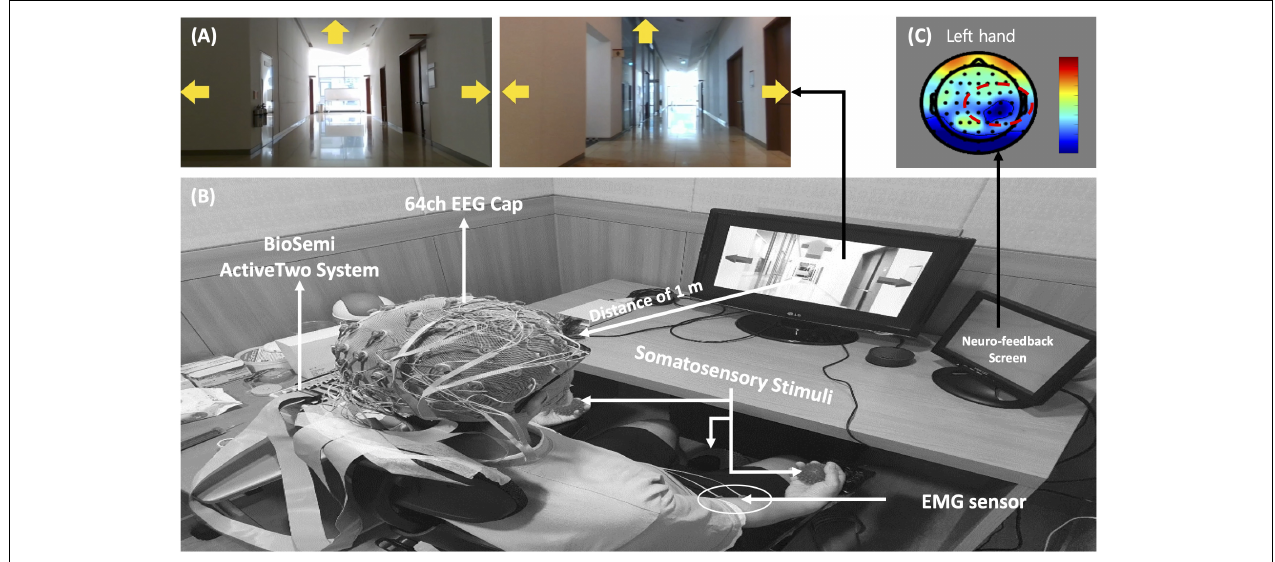
FIGURE 1 | (A) Stimuli for motor imagery-based brain-computer interface task, (B) experimental environment, and (C) neuro-feedback mechanism.